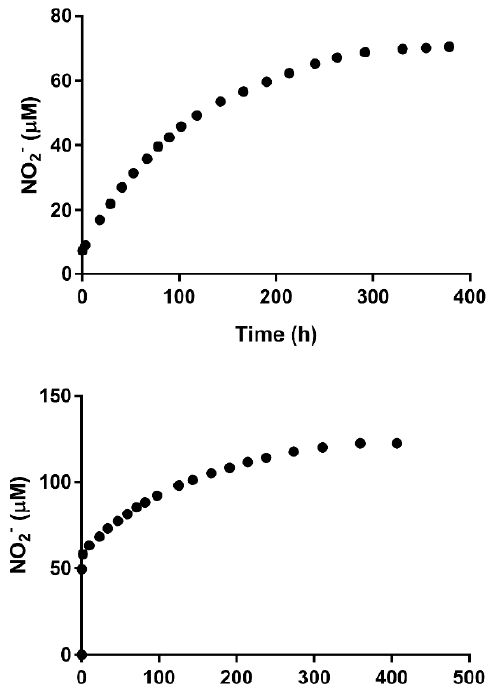
Figure 2. Cumulative nitrite release profiles quantified via Griess reaction assay. Top : Fmoc-PXG/NO peptide obtained from reaction of 30 µ M Fmoc-PXG solution with NO (g) that resulted in 60% functionalization. Bottom : Fmoc-PXG/NO peptide obtained from reaction of 400 µ M Fmoc-PXG solution with NO (g) that resulted in 14% functionalization.